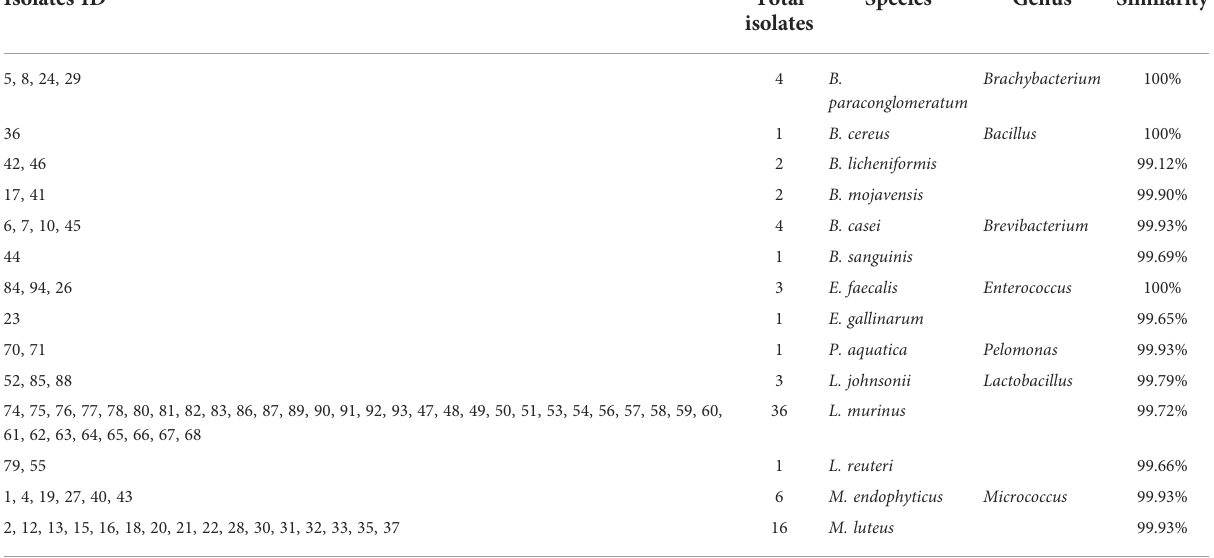
The 16S rRNA gene sequences of the isolates in Table 2 have been deposited in GenBank databases under the accession numbers ON974317-ON974397.